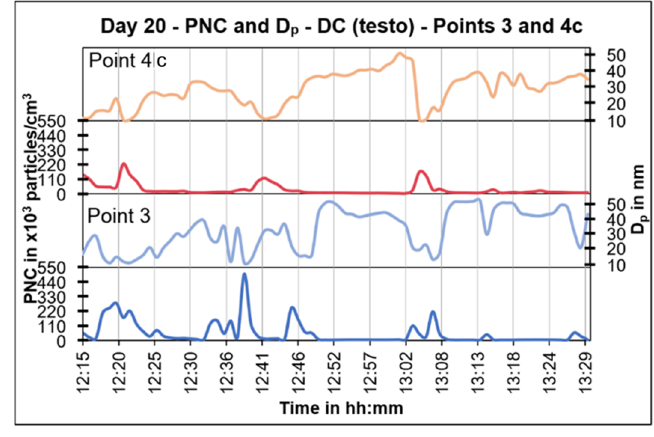
Figure 16. Parallel measurements at points 3 and 4c.